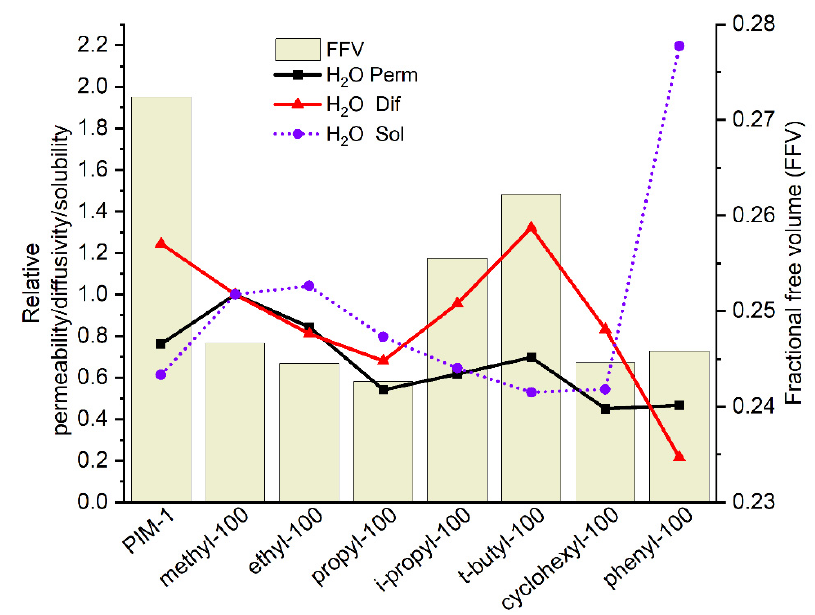
Figure 11. H 2 O relative permeability relative diffusivity, relative solubility and FFV of homopolymers. (Relative permeability or diffusivity or solubility: homopolymer water permeability or diffusivity or solubility are normalized to methyl-100 water permeability or diffusivity or solubility.)